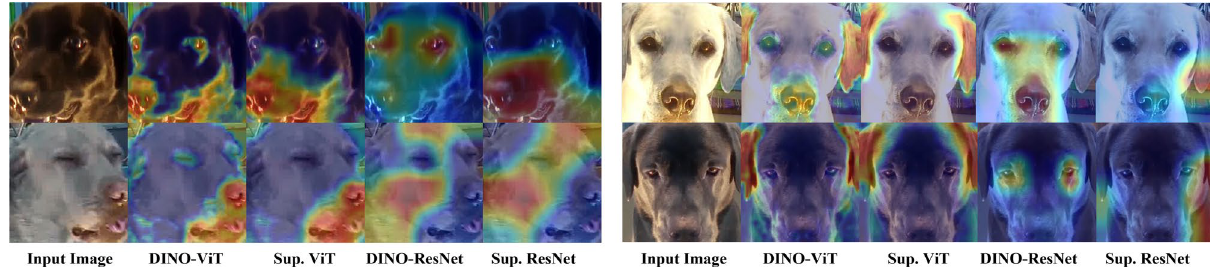
Figure 6. EigenCAM 59 activation maps on several images for our four different models. The images in the top and bottom row are from positive and negative classes respectively. The DINO-ViT backbone addresses similar areas to those proposed by human annotated DogFACS